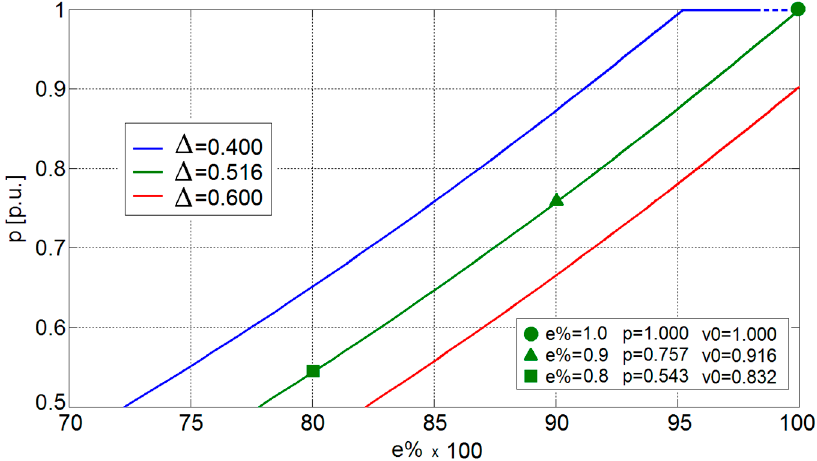
Figure 8. Power reduction function for preserving different values of stability index Δ .